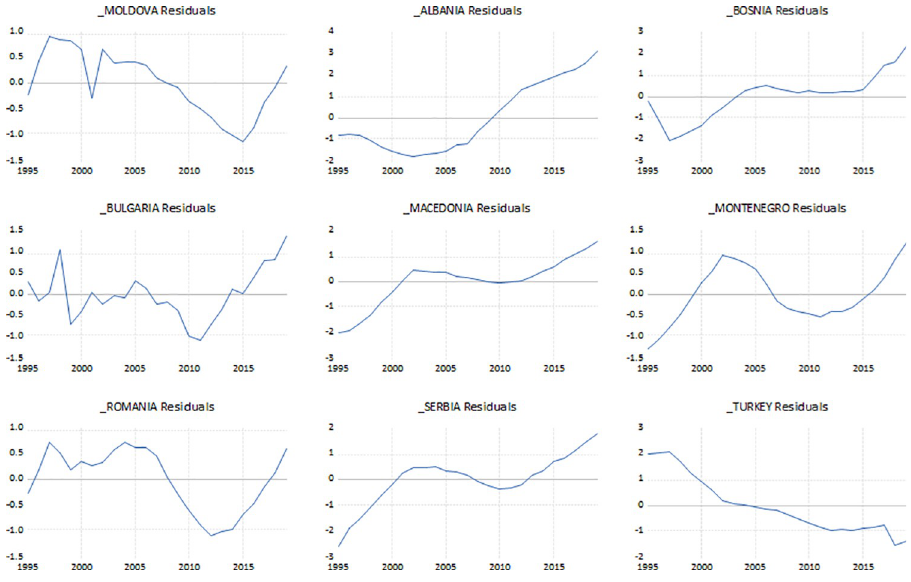
Fig 5. Fixed effect residual country plot graph. Source: Author’s design based on World Bank and UN data.